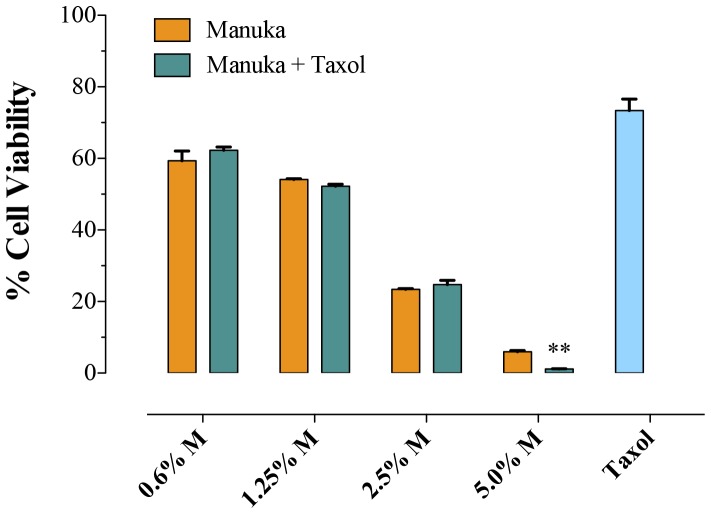
Co-treatment with manuka and taxol results in additive effect.B16.F1 cells were seeded at 1×103 cells per well in a 96-well plate and incubated with the indicated concentrations of manuka, alone or in combination with taxol (10 ng/ml), for 72 hrs. Cell viability was determined using CellTiter-Glo luminescent assay. Results are expressed as percentage viability in treated cell cultures compared to untreated cells and are representative of 3 independent experiments. Asterisks denote statistically significant differences between corresponding cell cultures treated with each manuka concentration in absence or presence of taxol (*, p<0.05).